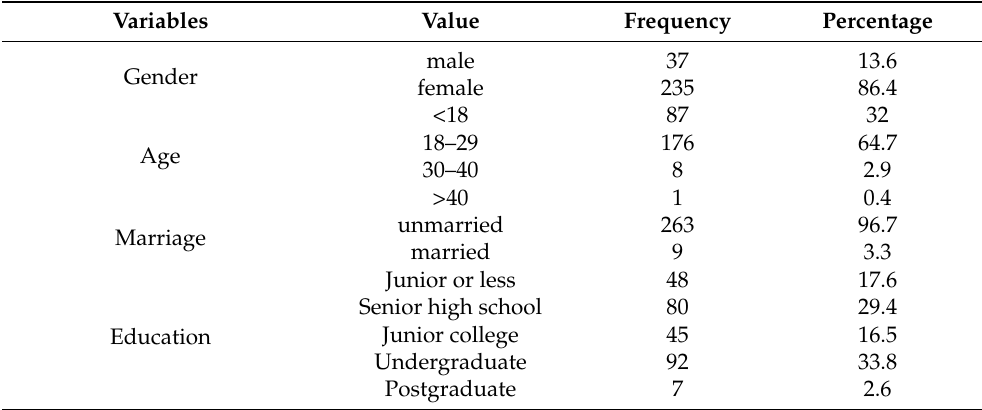
Table 3. Demographic data of